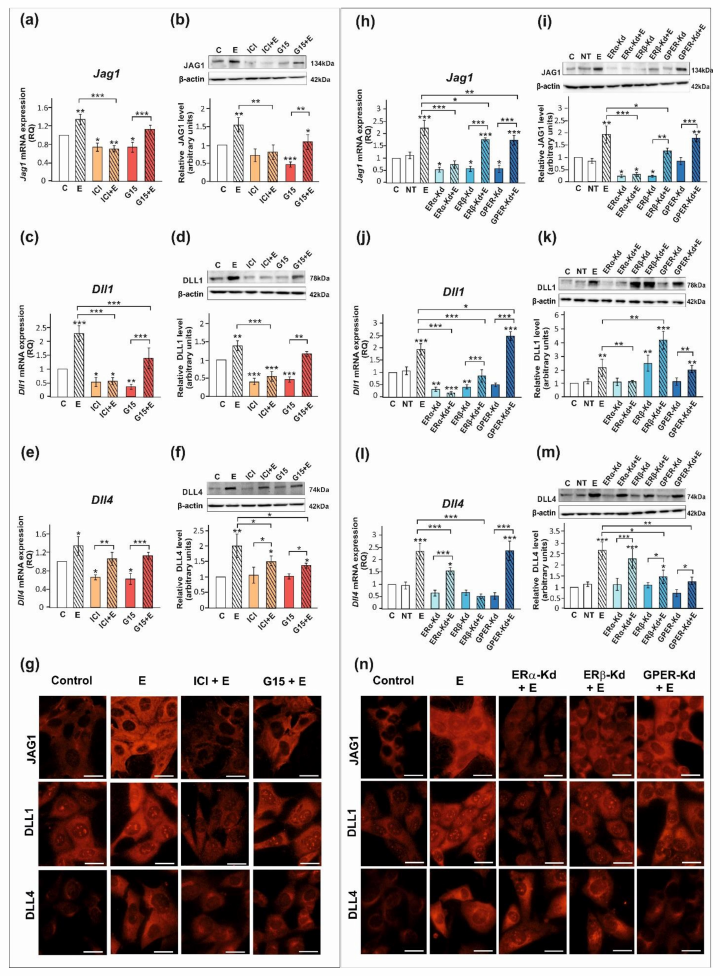
Figure 4. The effect of estrogen receptor antagonists or estrogen receptor silencing on mRNA and protein expression of Jag1 /JAG1, Dll1 /DLL1, and Dll4 /DLL4 in TM4 Sertoli cell line. ( a – g ) Cells were treated with 10 − 9 M 17 β -estradiol (E), 10 − 6 M ICI 182,780 (ICI), ICI + E, 10 − 8 M G15, G15 + E, or vehicle (C) for 24 h. ( h – n ) Cells were treated with transfection reagent alone (C), transfection reagent + 5 × 10 − 8 M non-targeting siRNA (negative control, NT), transfection reagent + 5 × 10 − 8 M ER α siRNA (ER α -Kd), ER β siRNA (ER β -Kd), or GPER siRNA (GPER-Kd). After 24 h, 17 β -estradiol or vehicle was added to the culture. ( a , c , e , h , j , l ) Relative expression of mRNAs (RQ) was determined using real-time RT-PCR analysis. The expression values of the individual genes were normalized to the mean expression of the reference genes. ( b , d , f , i , k , m ) Western blot detection of the proteins. The relative level of studied protein was normalized to β -actin. The protein levels within the control group were arbitrarily set at 1. The histograms are the quantitative representation of data (mean ± SD) of three independent experiments, each in triplicate. Significant differences from control values are denoted as * p < 0.05, ** p < 0.01, and *** p < 0.001. ( g , n ) Immunofluorescence analysis of JAG1, DLL1, and DLL4 expression. Scale bar = 10 µ